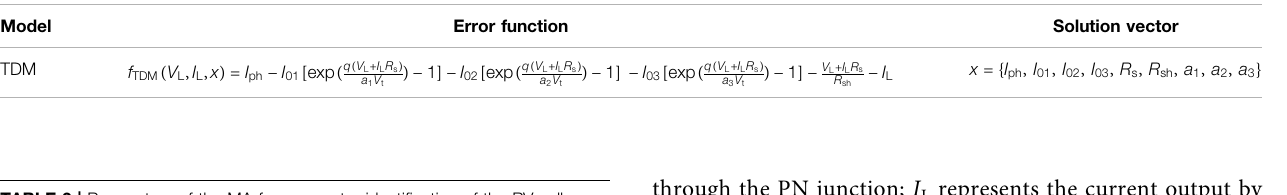
TABLE 3 | Parameters of the MA for parameter identi fi cation of the PV cell. Parameter